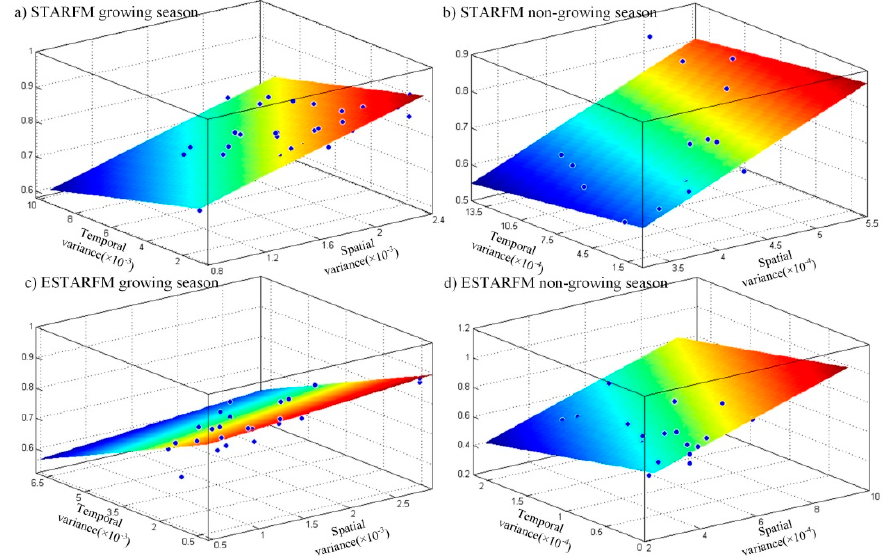
Figure 10. Fitting surface and its samples. ( a , c ) respectively represent the STARFM and ESTARFM fitting result in the growing season, while ( b , d ) indicate the non-growing season fitting results of STARFM and ESTARFM, respectively.